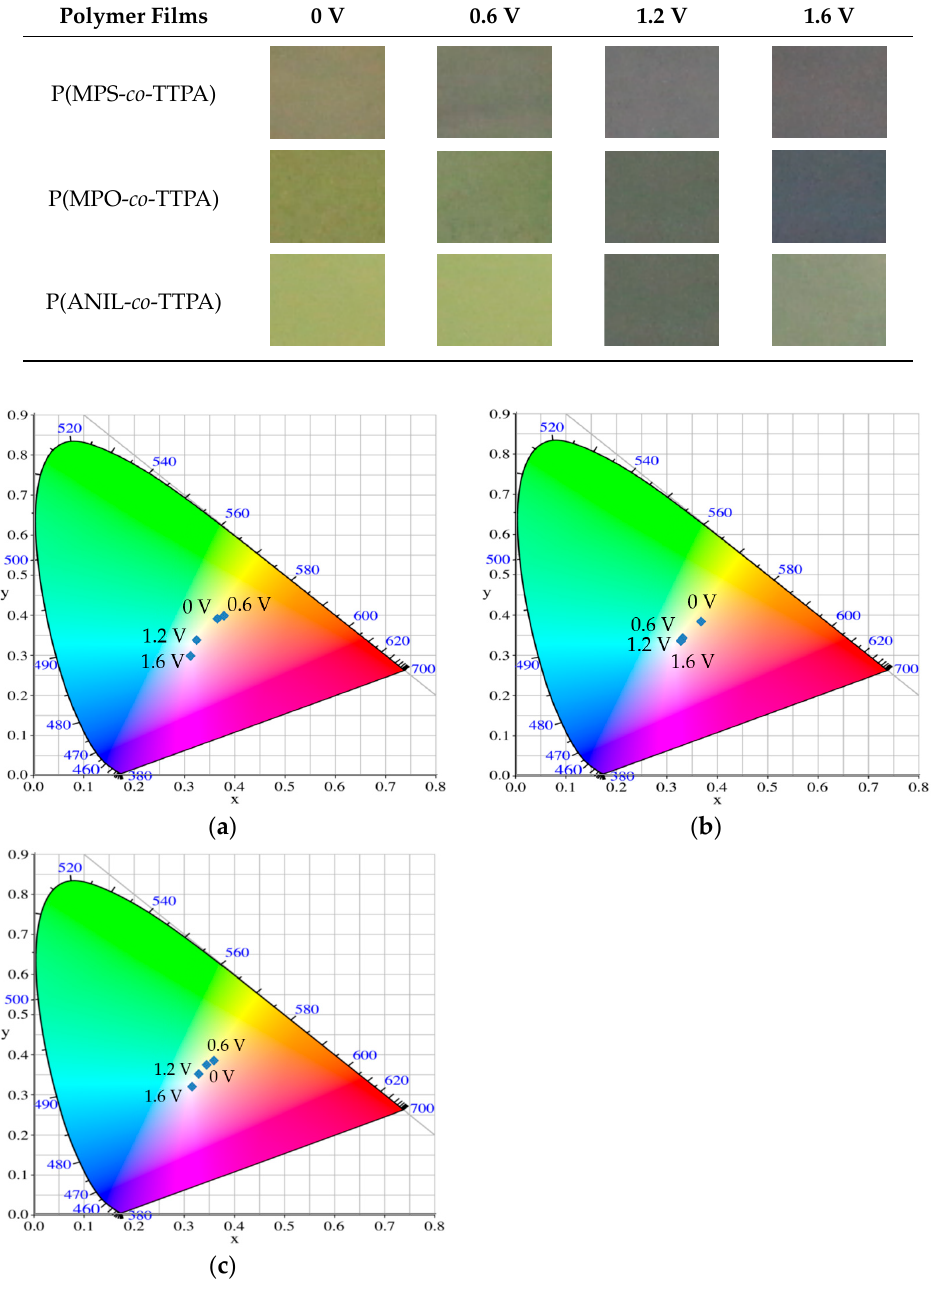
Table 2. Electrochromic behaviors of copolymer films at various voltages.